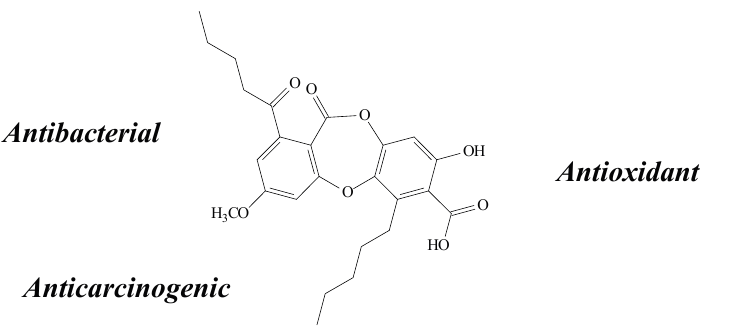
Figure 6. Lobaric acid structure and biological